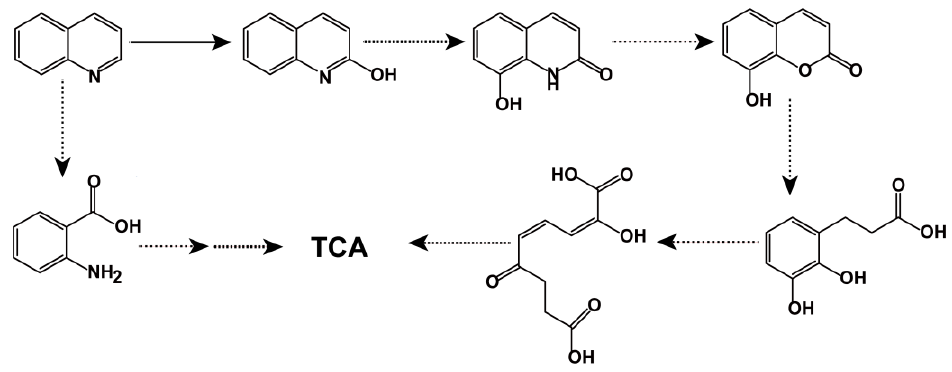
Figure 5. The proposed quinoline biodegradation pathway of strain JH145.